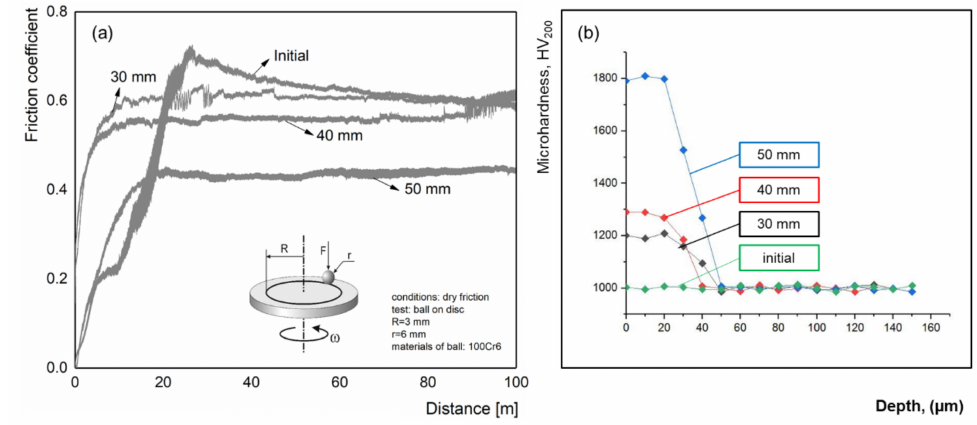
Figure 10. Results of tribological studies ( a ) and microhardness on the cross-section of the coatings ( b ). Hardness measurements across the cross-section of the surface layer are shown in Figure 10b. Microhardness values were measured in three zones along the thickness of the cross-section of the coating, and the measurements corresponding to the transition zone were considered. Figure 10b shows that the microhardness of the surface after PPT and the microhardness of the near-surface layers of the coatings are greater compared to the untreated coating. The thickness of the hardened layer (modified by the PPT method) is 20–30 microns. Subsequently, the microhardness decreases to 1000 HV and remains at the level of the microhardness value of the coatings before the PPT (in the initial